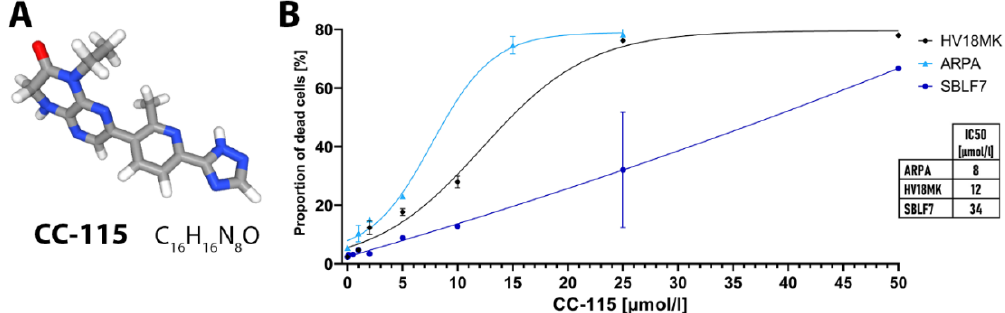
Figure 1. Structural formula of CC-115 and dose escalation study. ( A ) Chemical structural formula of CC-115 (C16H16N8O) [54] ( B ) Healthy donor skin fibroblasts (SBLF7) and patient derived melanoma cells (ARPA, HV18MK) were treated for 48 h in a dose escalation study with 0.1 – 25 µmol/L CC-115. Dead cells were defined as sum of apoptotic and necrotic cells measured using flow cytometry (apoptosis/necrosis analysis by Annexin V-APC/7-AAD staining). Half maximal inhibitory concentrations (IC50) for the di ff erent cell line are displayed. Each value represents mean ±